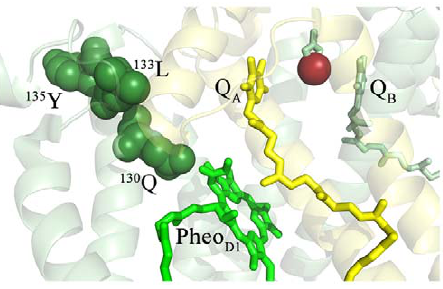
Figure 3. Detail of the Oxidized Residues in the Vicinity of Q A . A close-up of the Q A – Non-Heme Iron – Q B region is shown. The T. vulcanus residues corresponding to the oxidatively modified spinach residues (Table 1) are highlighted and labeled. The D1 protein is shown in pale green and the D2 protein is shown in pale yellow. The oxidatively modified residues of D1 are shown in dark green while those of D2 are shown in orange, with the individual modified residues being labeled. Q A is shown in yellow, Q B in green and the non-heme iron is shown in bright red.